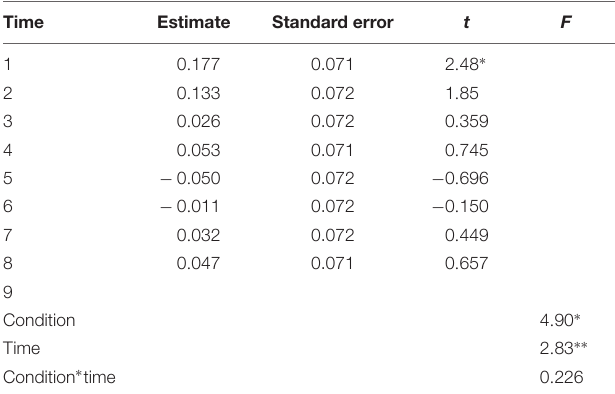
TABLE 2 | The effect of smartphone restriction on withdrawal (SWS) scores by linear mixed